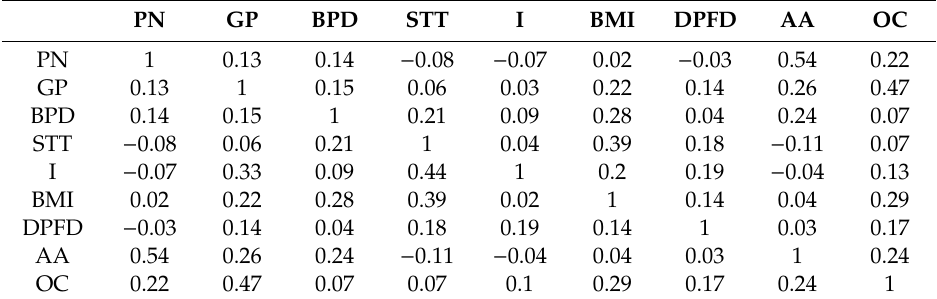
Table 1. Correlation matrix between experimental dataset attributes.